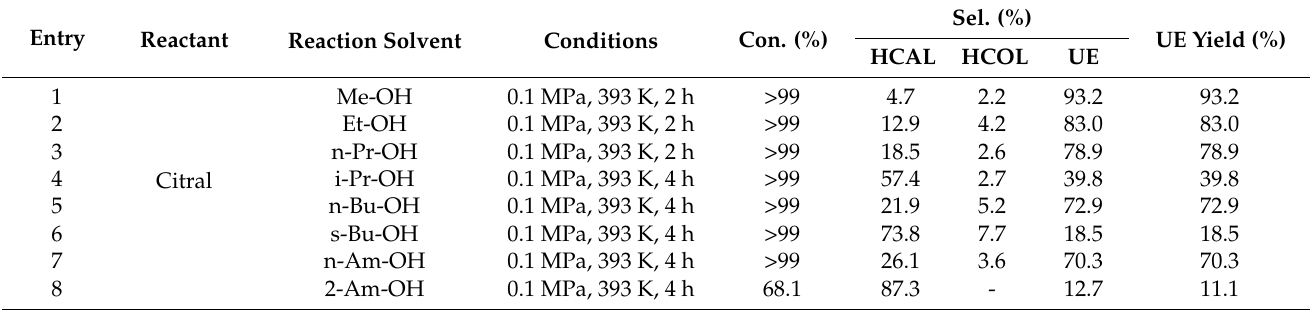
Table 4. Catalytic hydrogenation performance over (AlPO 4 ) 0.1 /Ni 2 P catalyst for citral with varying reactants and reaction conditions. HCAL: Citronellol; HCOL: 3,7-Dimethyloctanol; UE: